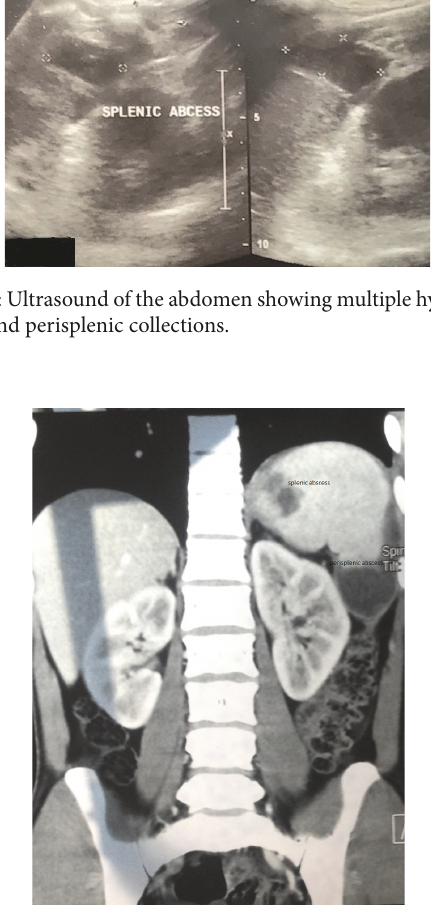
Figure 2: Contrast-enhanced computed tomography of the abdomen showing multiple hypodense lesions in and around the spleen.